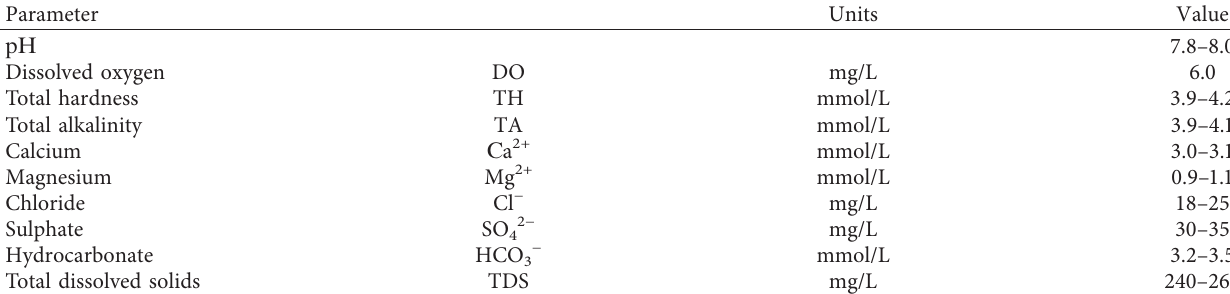
Table 1: Water chemical